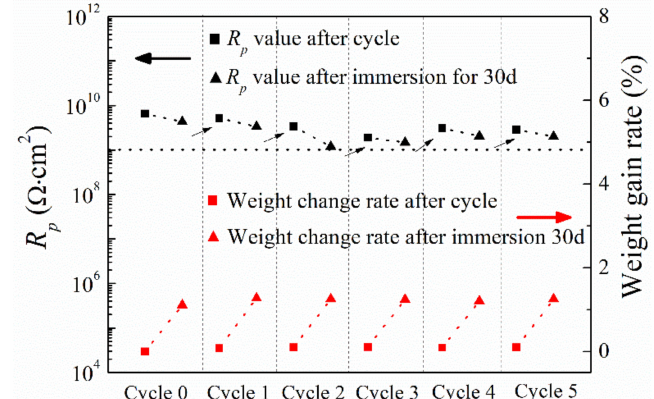
Figure 12. The change of the R p value and the weight change rate of the C-EC / TPU under di ff erent cycle test